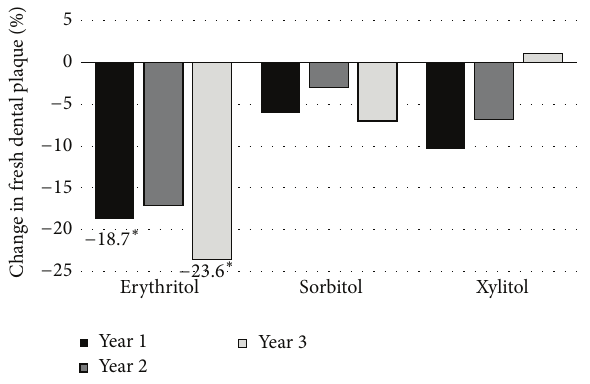
Figure 9: Percent change in dental plaque weight against baseline over a 3-year period in a child cohort consuming erythritol-, sorbitol-, or xylitol-containing candies. Adapted from Runnel et al. [40]. ∗ 𝑝 < 0.05 when compared to baseline using the Wilcoxon Signed Rank test with the Bonferroni